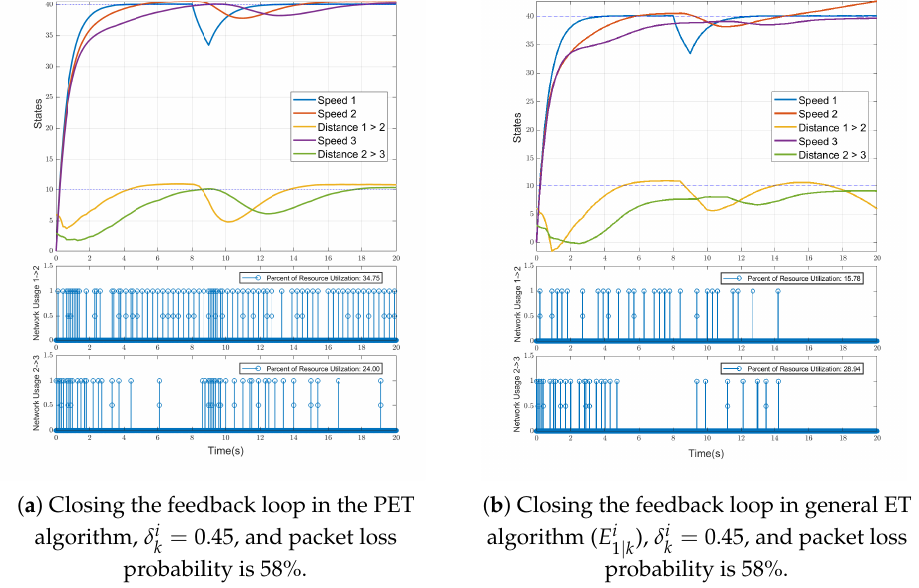
Figure 5. The graphs show, from top to bottom, the states of vehicles in platoon (speeds (km h − 1 ), relative distance (m)), the network usage between vehicles 1 → 2, and 2 → 3. The value of the resource utilization is mentioned on the graphs as previously